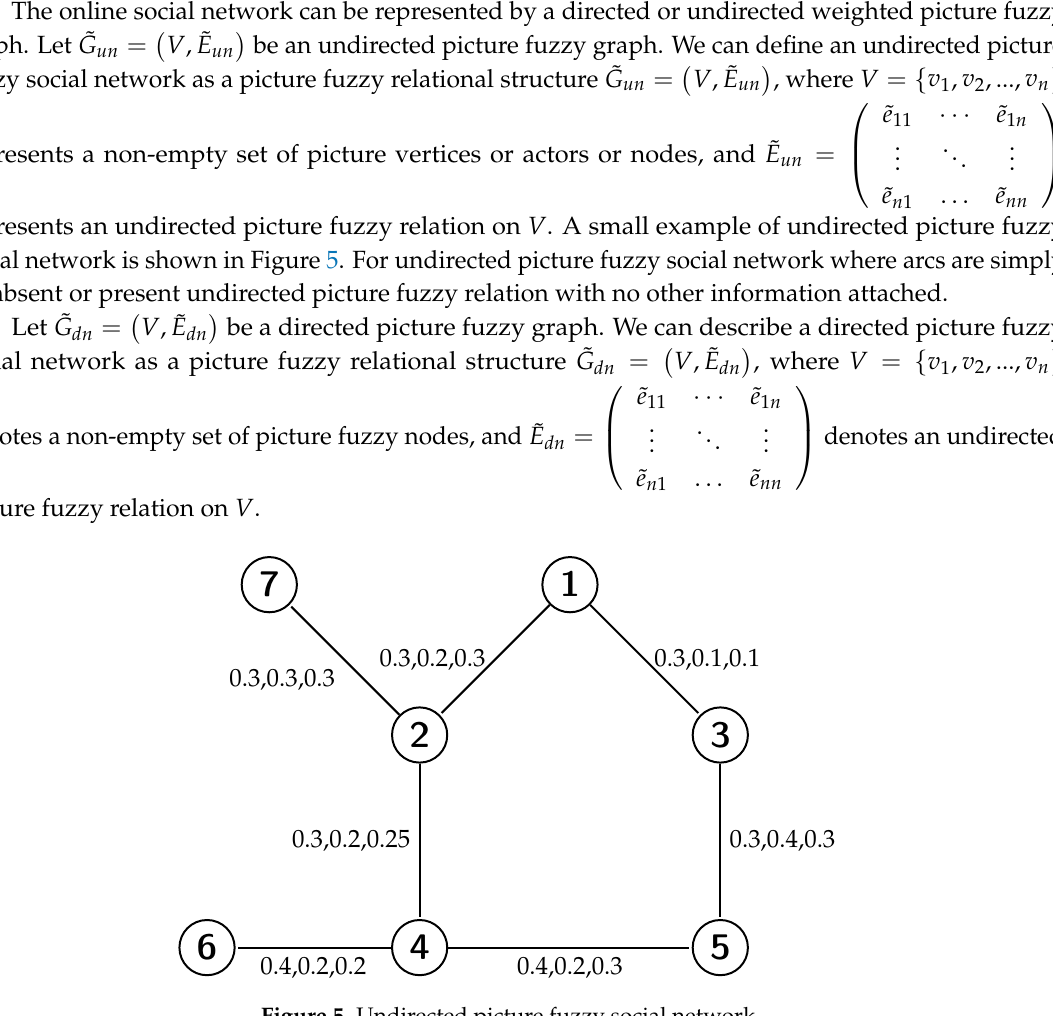
Figure 5. Undirected picture fuzzy social